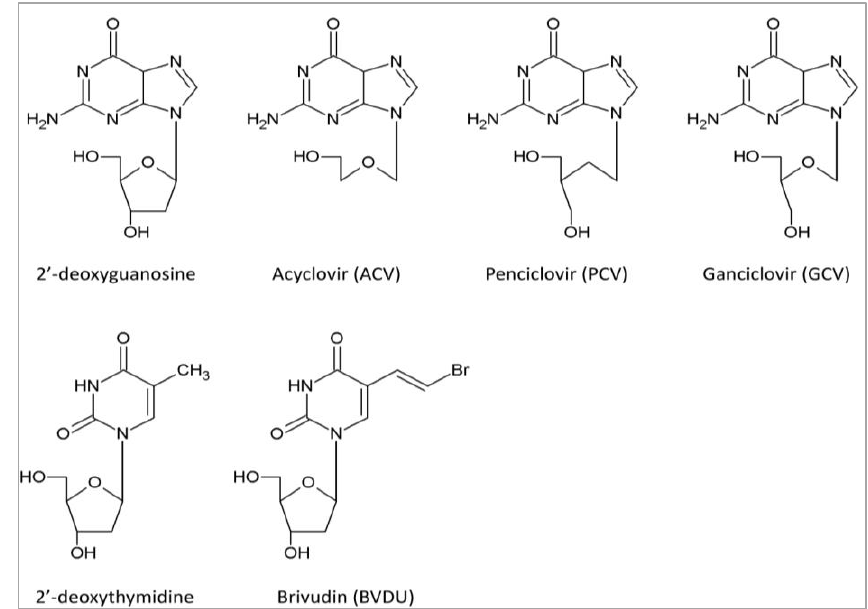
Figure 1. Structures of currently approved nucleoside analogs for herpesvirus infections. Acyclovir (ACV), penciclovir (PCV), ganciclovir (GCV) are derivatives of the natural nucleoside 2’-deoxyguanosine, whereas brivudin (BVDU) is an analog of the natural nucleoside